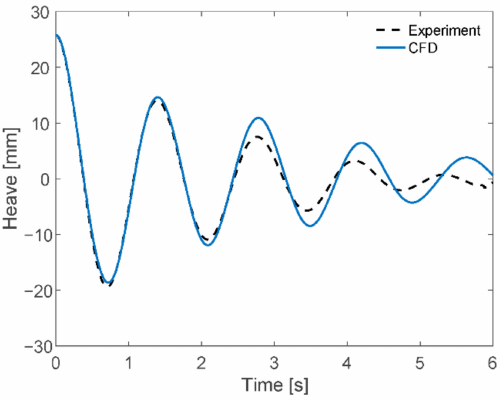
Figure 6. Comparison of experiment and CFD simulation of heave motion.